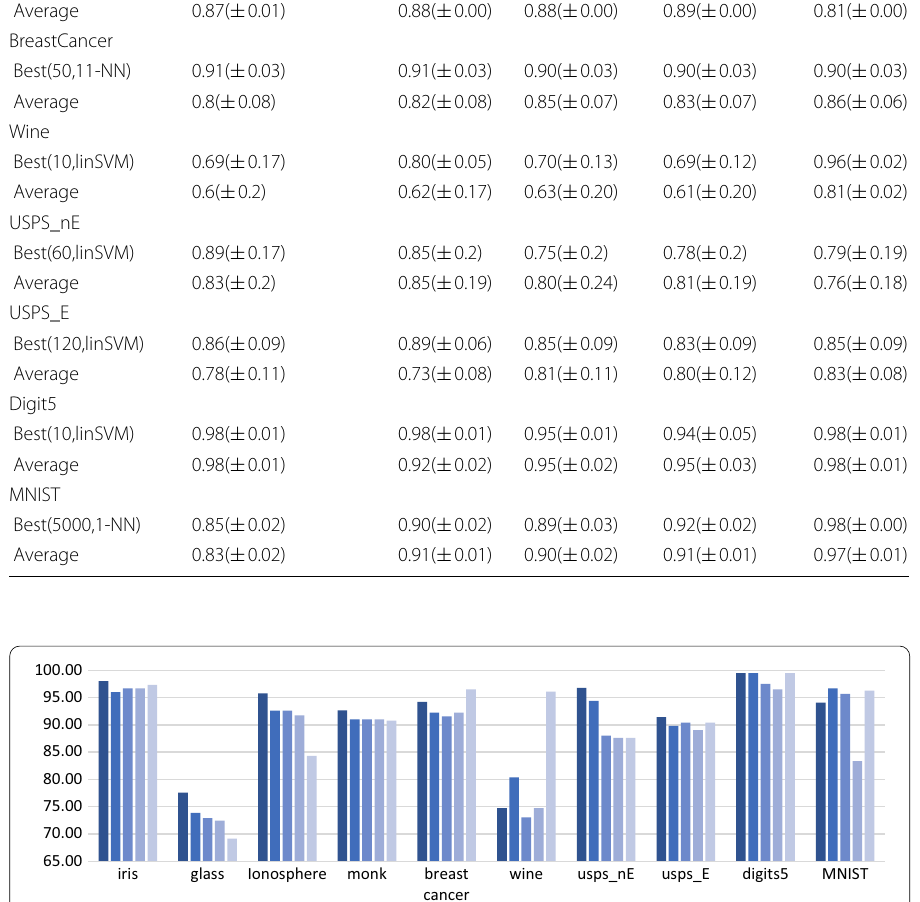
the structural data is embedded into the dissimilarity space and then the common proto- type generation methods are applied. In 2017 a measure of ultrametricity is introduced for creating dissimilarity space [36]. Then the performance of KNN classifier on the